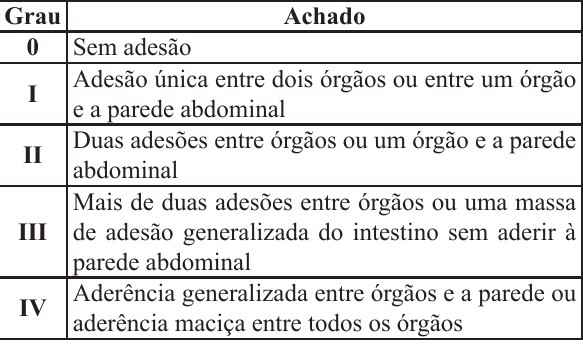
1 cm para exame histopatológico e colocada em formol a 10%. O restante da peça foi colocado em outro frasco com solução salina a 0,9% para estudo tensiométrico. Cada fra - sco recebeu identificação com o nome do grupo, subgrupo e identificação do animal.